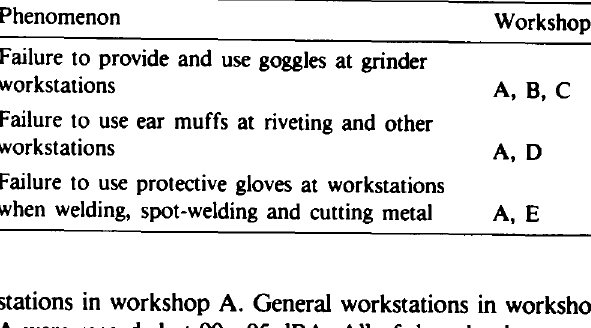
Table 1 Showing details of unsafe phenomena re vealed from the pre-experimental